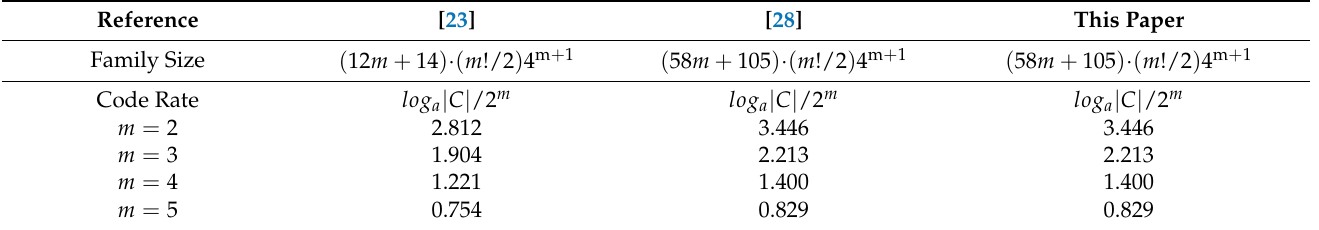
Figure 4. Comparison of the family sizes of 16-QAM GCSs when q = 2 between [23] and this paper. Table 2. Comparison of the code rates and family sizes of 16-QAM GCSs when q =